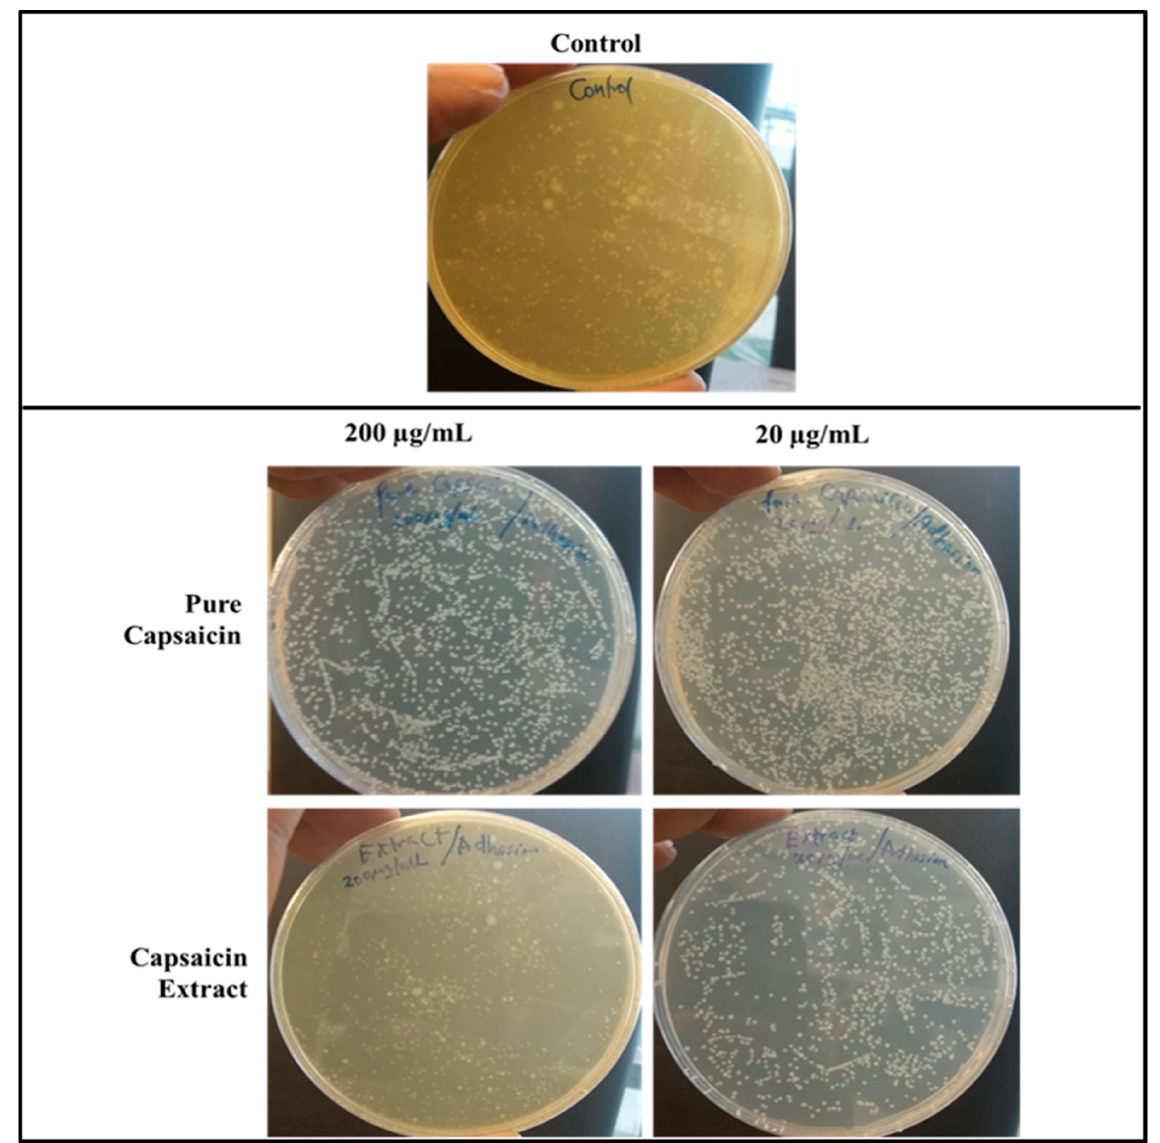
Figure 8. Images of Agar plates depicting the CFUs of S. typhimurium in bacteria adhesion assay. Monolayer Vero cells grown in media supplemented with capsaicin at varying concentrations were infected with S. typhimurium and incubated for 30 min, washed thrice with 1X PBS to remove bacterial cells in suspension. Vero cells were then lysed with chilled distill water and plated on Agar plates overnight. The treated samples received capsaicin extract at 200 or 20 µg/mL respectively, whereas the control received 1X PBS.